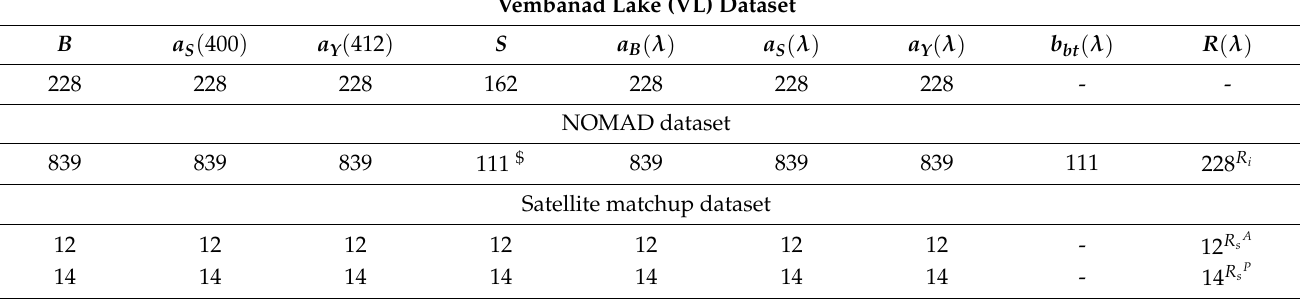
Table 1. Details of datasets used. Note that the λ represents the wavelengths—443, 490, 560, 665, and 683 or 705. The 683 nm was the longest band available for the reflectance from the NOMAD dataset, whereas the fifth band of MSI on Sentinel 2 is 705. There were N = 12 satellite matchups available for ACOLITE ( ρ wA ) and N = 14 for POLYMER ( ρ wP ) data used for the reflectance model from Vembanad Lake (VL) dataset. The superscript ‘$’ denotes that the S values were estimated using Equation